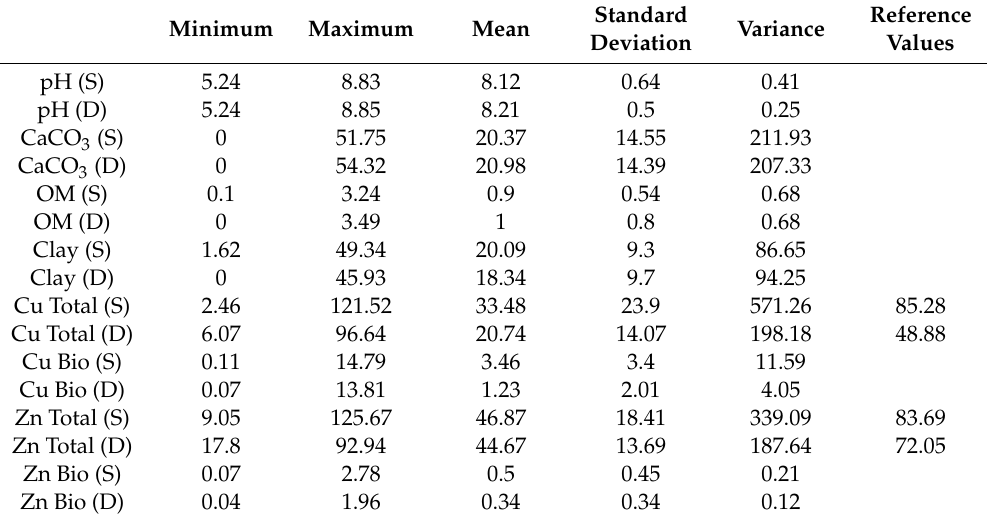
Table 1. Statistical values of measured soil properties (pH, CaCO 3 : calcium carbonate %, OM: organic matter %, and Clay: clay contents %) and trace elements concentration (mg kg − 1 ) of the total and plant-available (BIO) Cu and Zn contents in 212 vineyard soil samples at the surface (S) and at depth (D). Additionally shown are pedogeochemical baselines (RV), given in mg kg − 1 , for Cu and Zn in the DOCa Rioja